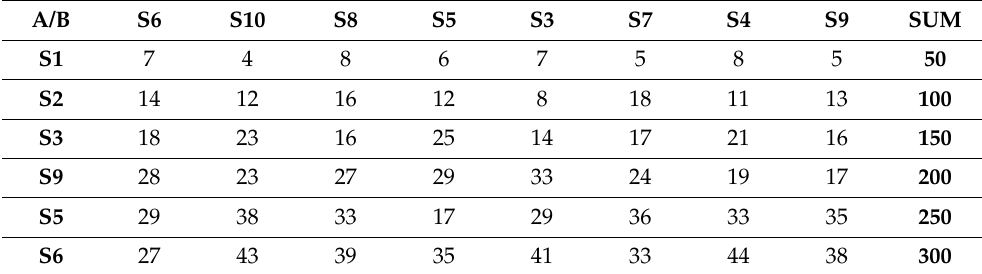
Table 2. Satellites transactions between Swarm A, and B (size of a transaction is 2049 bytes).